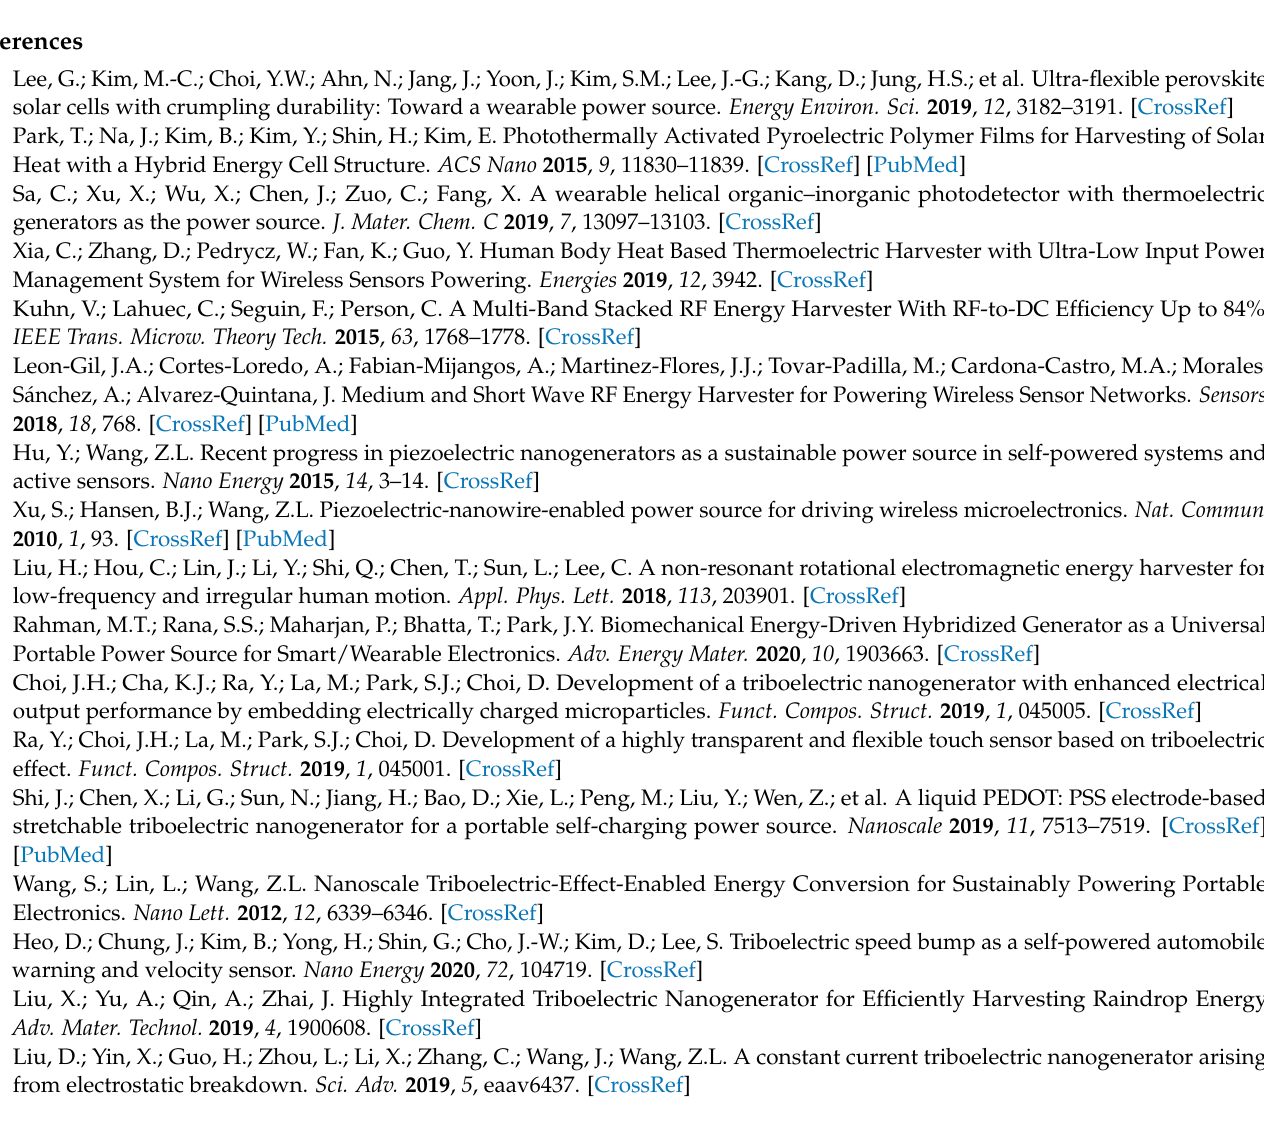
depending on number of wings, Figure S3: Photographs of the fabricated Y-TENG, Figure S4: Voltage and power output according to external load